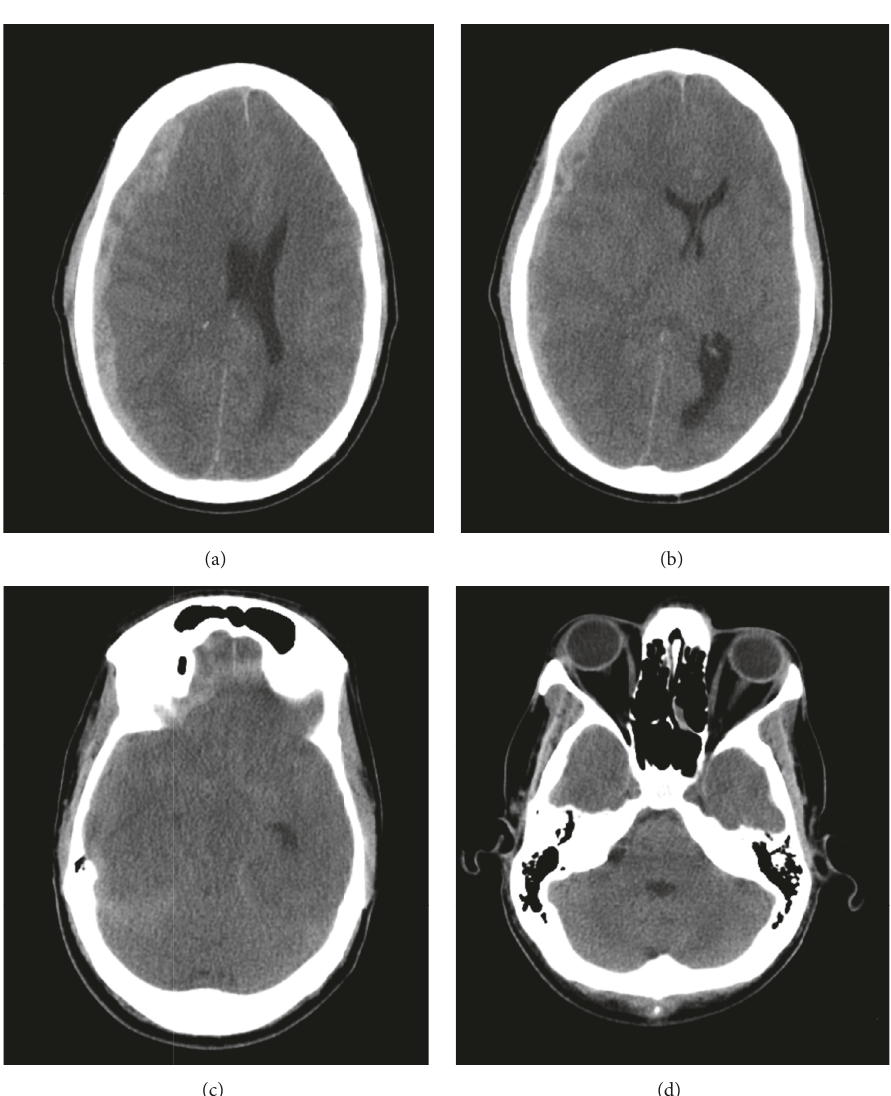
Figure 1: Initial CT scan showing panhemispheric, mixed density subdural mass with significant mass effect ((a) and (b)). There is significant effacement of the right temporal horn and basilar cisterns consistent with herniation (c), though the 4th ventricle is still patent